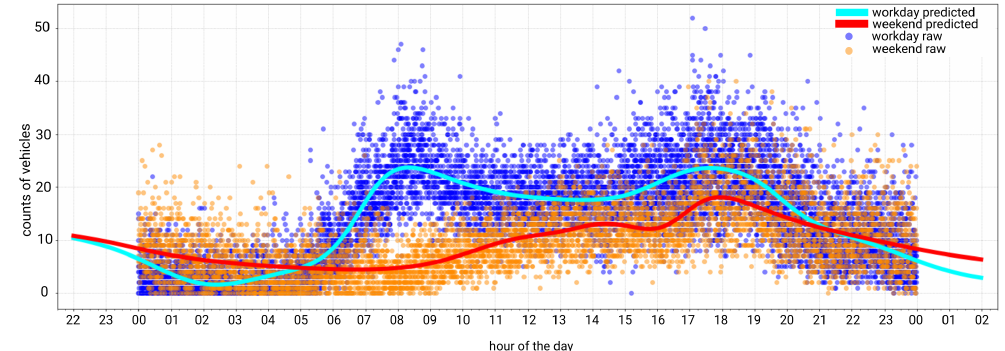
Figure 10. Response of neural network regressor trained on 2 weeks of data. Predicting the traffic volume given the minute of day. The two curves are predictions for workday (Monday–Tuesday in cyan) and weekend (Saturday/Sunday in red) with correspondingly colored training instances in the